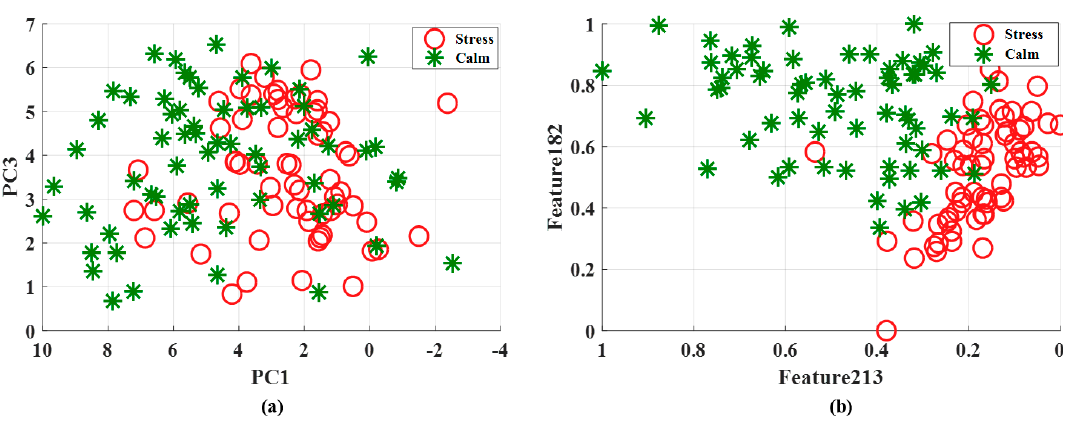
Figure 3. Comparison between ( a ) PCA and ( b ) GA-based feature selection. Table 4. Comparison of average precision of related stress classification from the EEG recording.